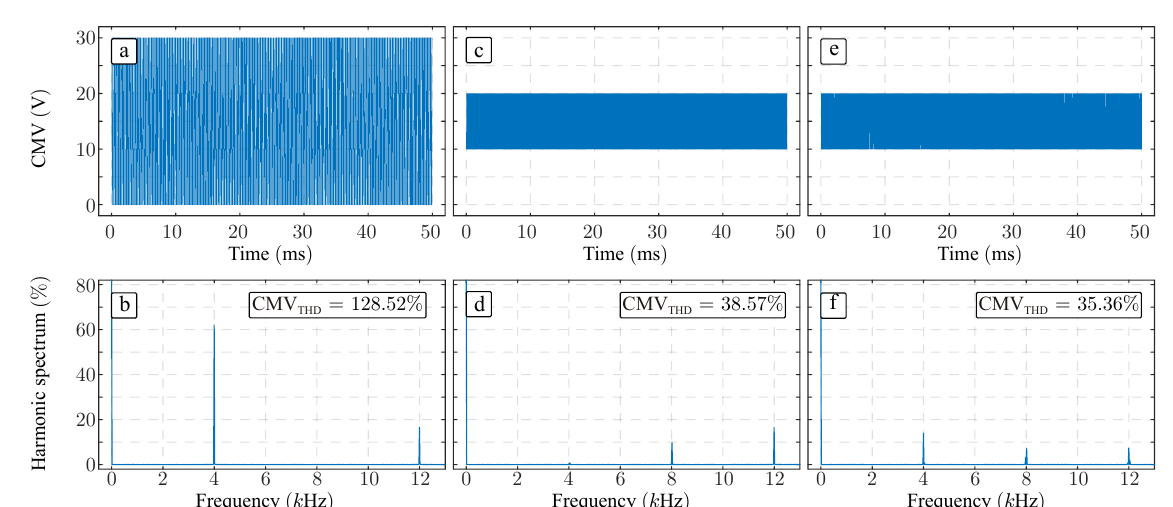
Figure 12. Results applying the traditional PWM method with [ φ a , φ b , φ c ] = [ 0,0,0 ] ◦ ( a ) CMV generated in the PMSM ( b ) CMV harmonic spectrum. Results applying the PWM method with [ φ a , φ b , φ c ] = [ 0,120,240 ] ◦ ( c ) CMV generated in the PMSM ( d ) CMV harmonic spectrum. Results applying the PWM method with [ φ a , φ b , φ c ] = [ 0, φ b generated in the PMSM ( f ) CMV harmonic